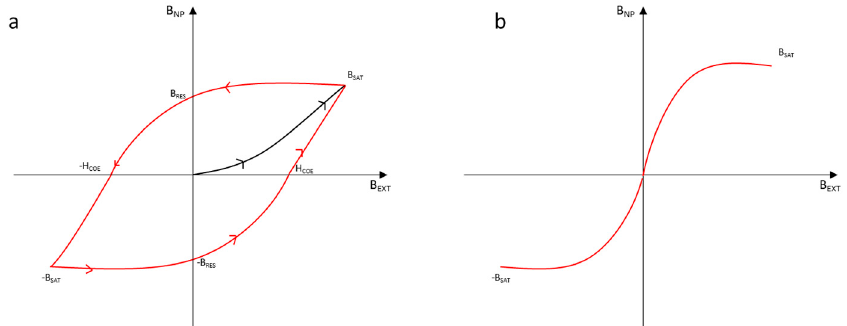
Figure 6. Route of the magnetic field provided by a NP (B NP ) depending on the external magnetic field (B ext ) applied for a ferromagnetic material ( a ) and a superparamagnetic material ( b ).